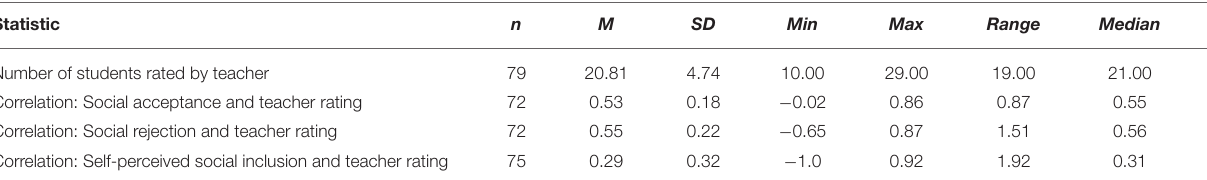
TABLE 5 | Variability of correlations between students’ sociometric status and teacher ratings.